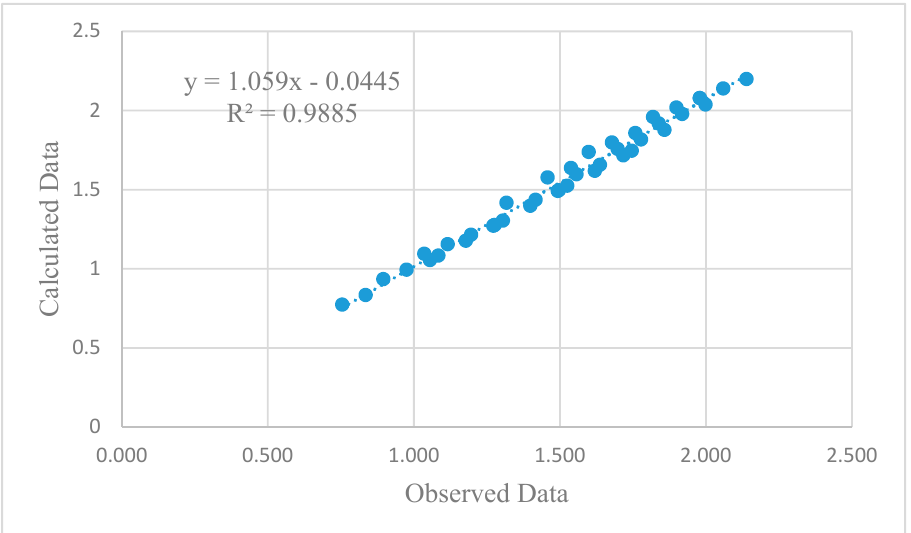
Figure 14. Results of the linear regression empirical equation to estimate the EE parameter.